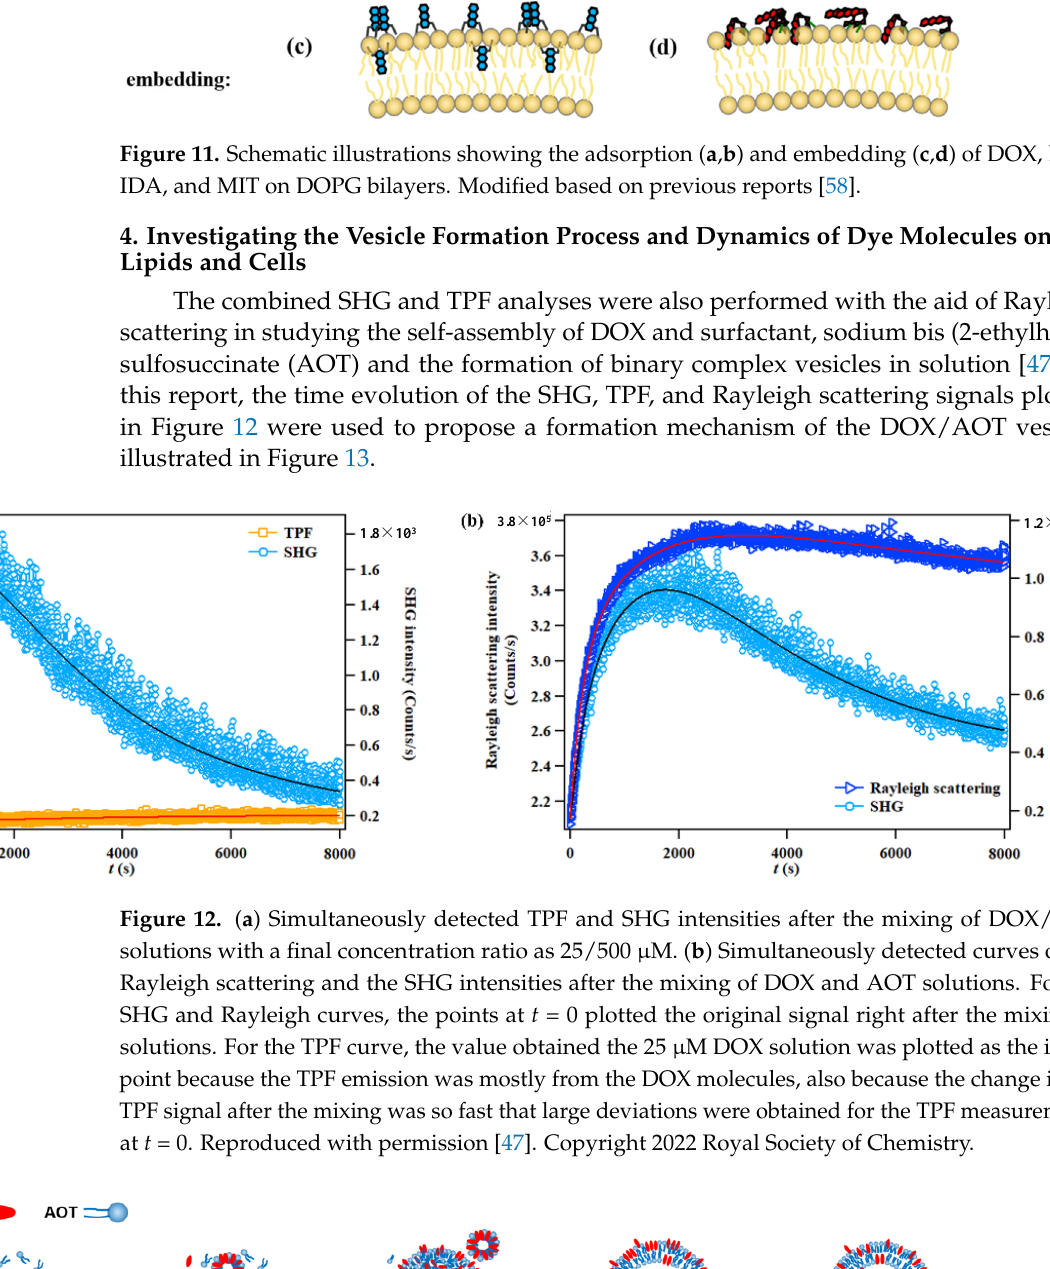
Figure 11. Schematic illustrations showing the adsorption ( a , b ) and embedding ( c , d ) of DOX, DNR, IDA, and MIT on DOPG bilayers. Modified based on previous reports [58].